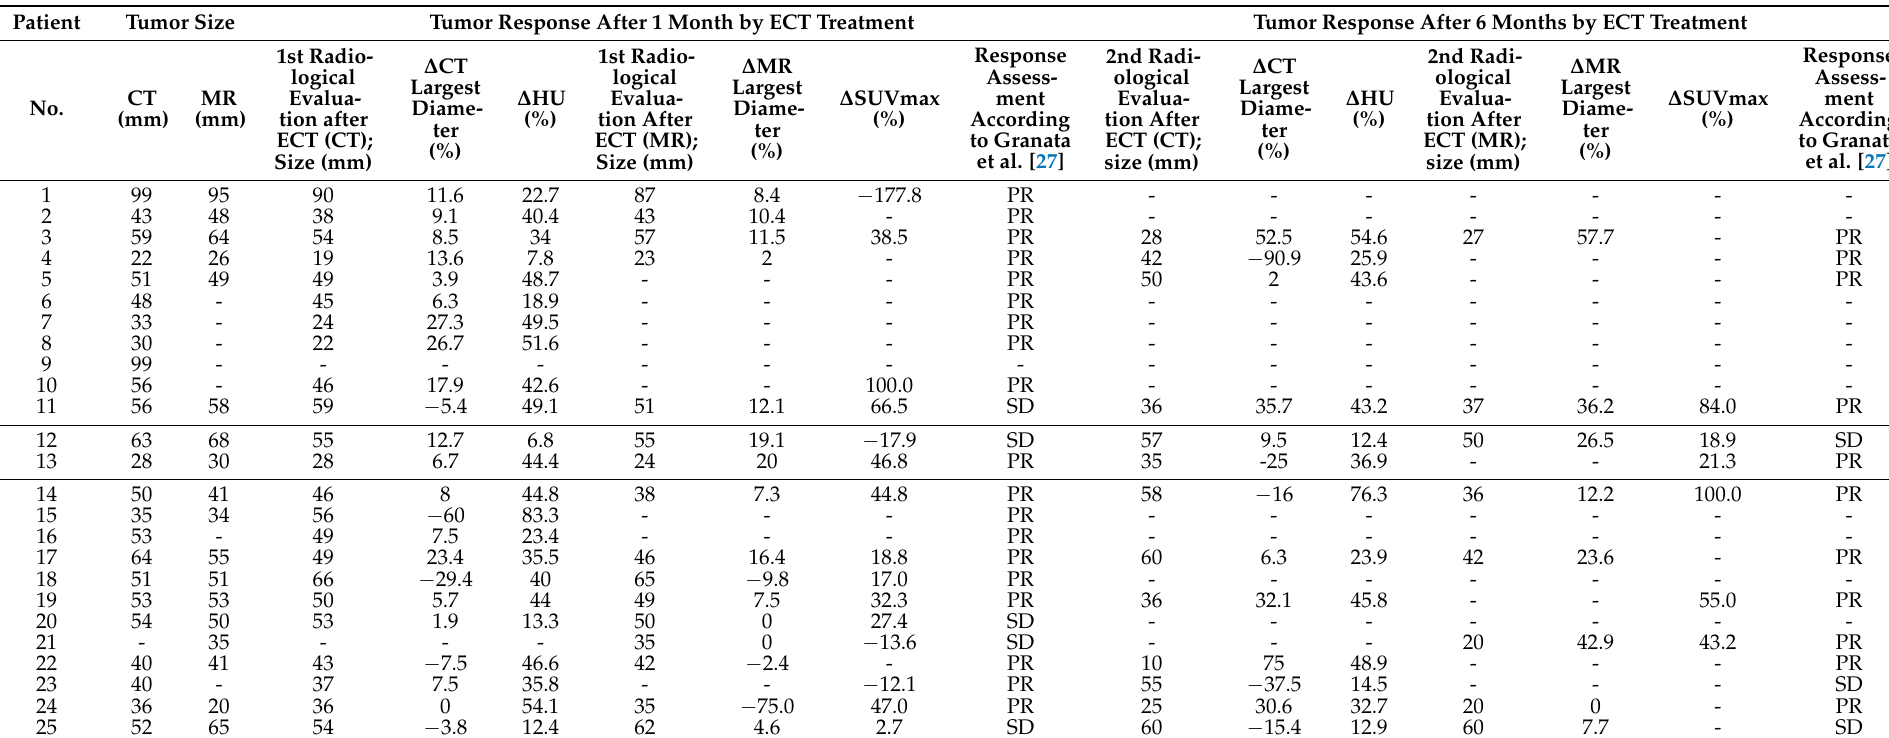
Table 3. Tumor size before and after electrochemotherapy for individual patients evaluated by magnetic resonance and computed